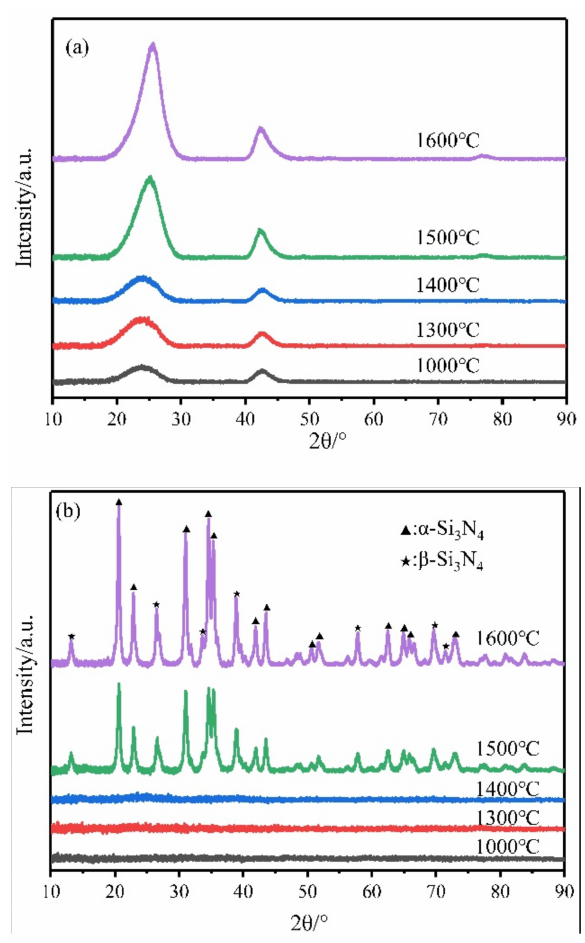
Figure 1. XRD patterns of ( a ) BN and ( b ) Si 3 N 4 pyrolyzed at different temperatures from PBN and